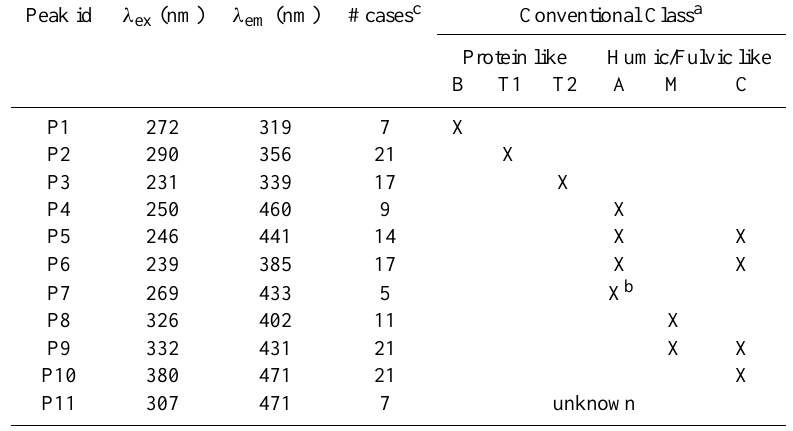
Table 2. Coordinates and brief description of each one of the eleven main peaks detected in the dataset after the deconvolution.